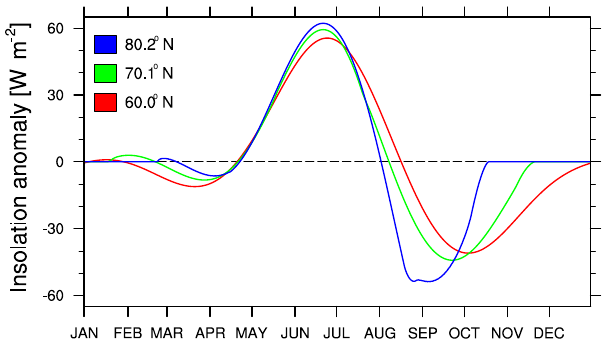
Figure 1. Insolation anomalies (Wm − 2 ) in the Eemian relative to PI (preindustrial period). The selected latitudes represent south- ern (60 ◦ N, red), middle (70 ◦ N, green), and northern (80 ◦ N, blue) Greenland. Axis markers indicate the beginning of each